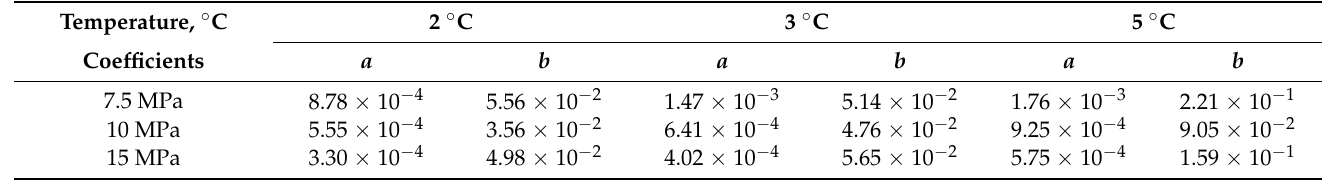
Table 2. Values of the coefficients of a and b